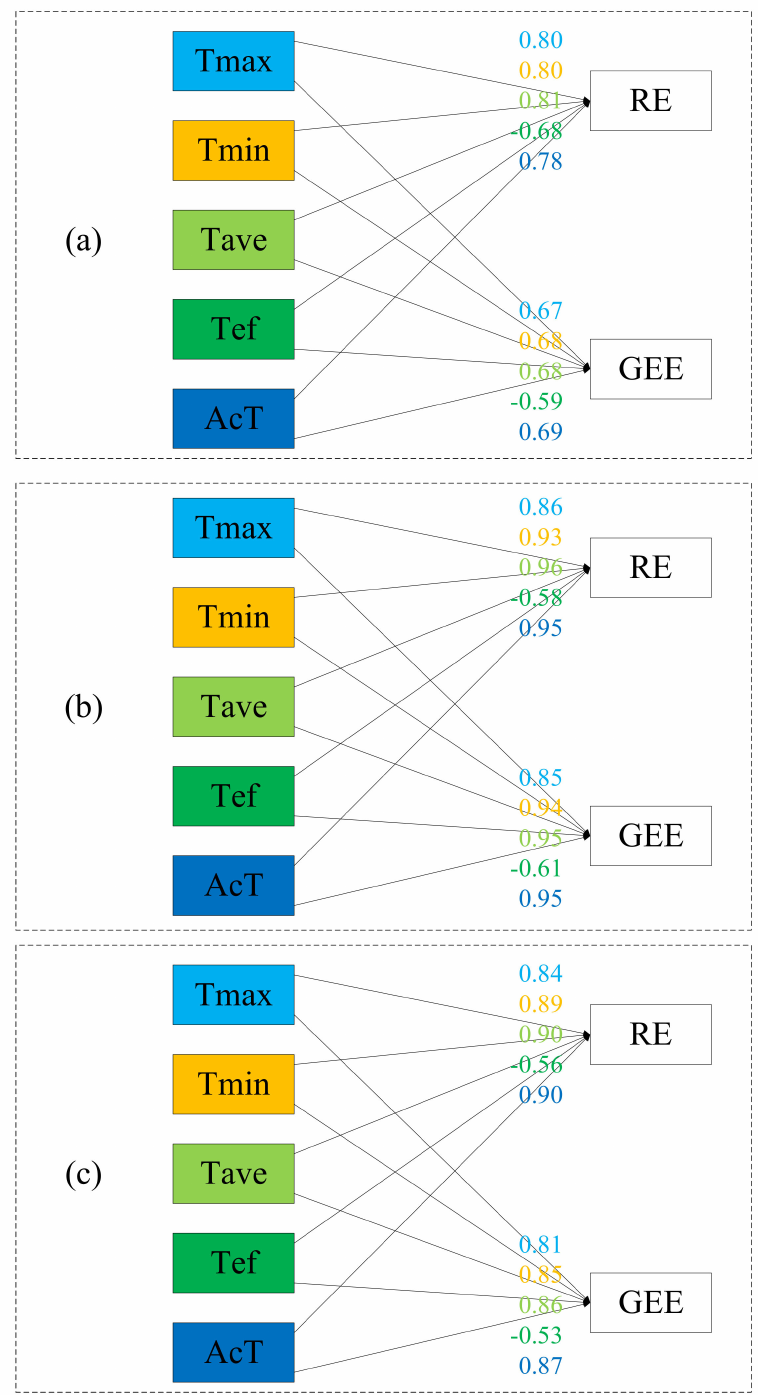
Figure 8. Correlation analysis of temperature index with ecosystem respiration and gross ecosystem exchange in temperate grassland ( a ), subtropical artificial coniferous forest ( b ), and tropical rain forest ( c ). Note: RE is ecosystem respiration, GEE is gross ecosystem exchange; the number is correlation coefficient; the above correlation coefficients are all found to be statistically significant at the p = 0.01 level; the same color corresponds to the corresponding